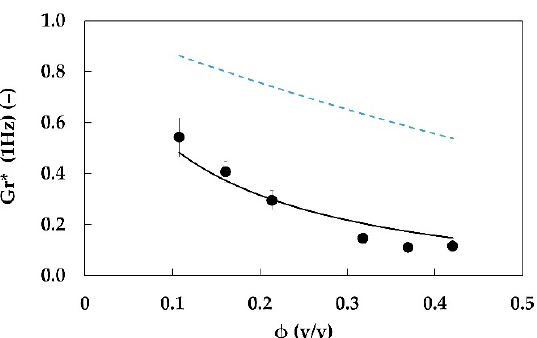
Figure 9. Relative complex modulus of emulgels as a function of volumetric fraction φ ; experimental data (black circles) are compared with the Palierne model (Equation (15) (dashed blue line)) and a modified Palierne model (Equation (18) (solid black line)).